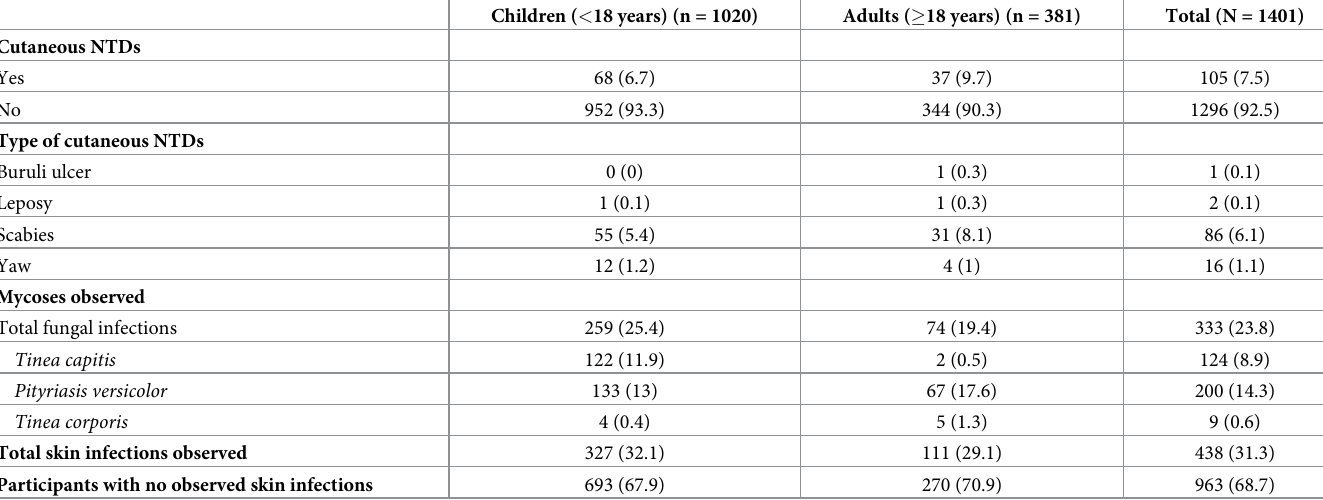
Table 2. Skin NTDs and mycoses observed, differentiated between children and adults, N